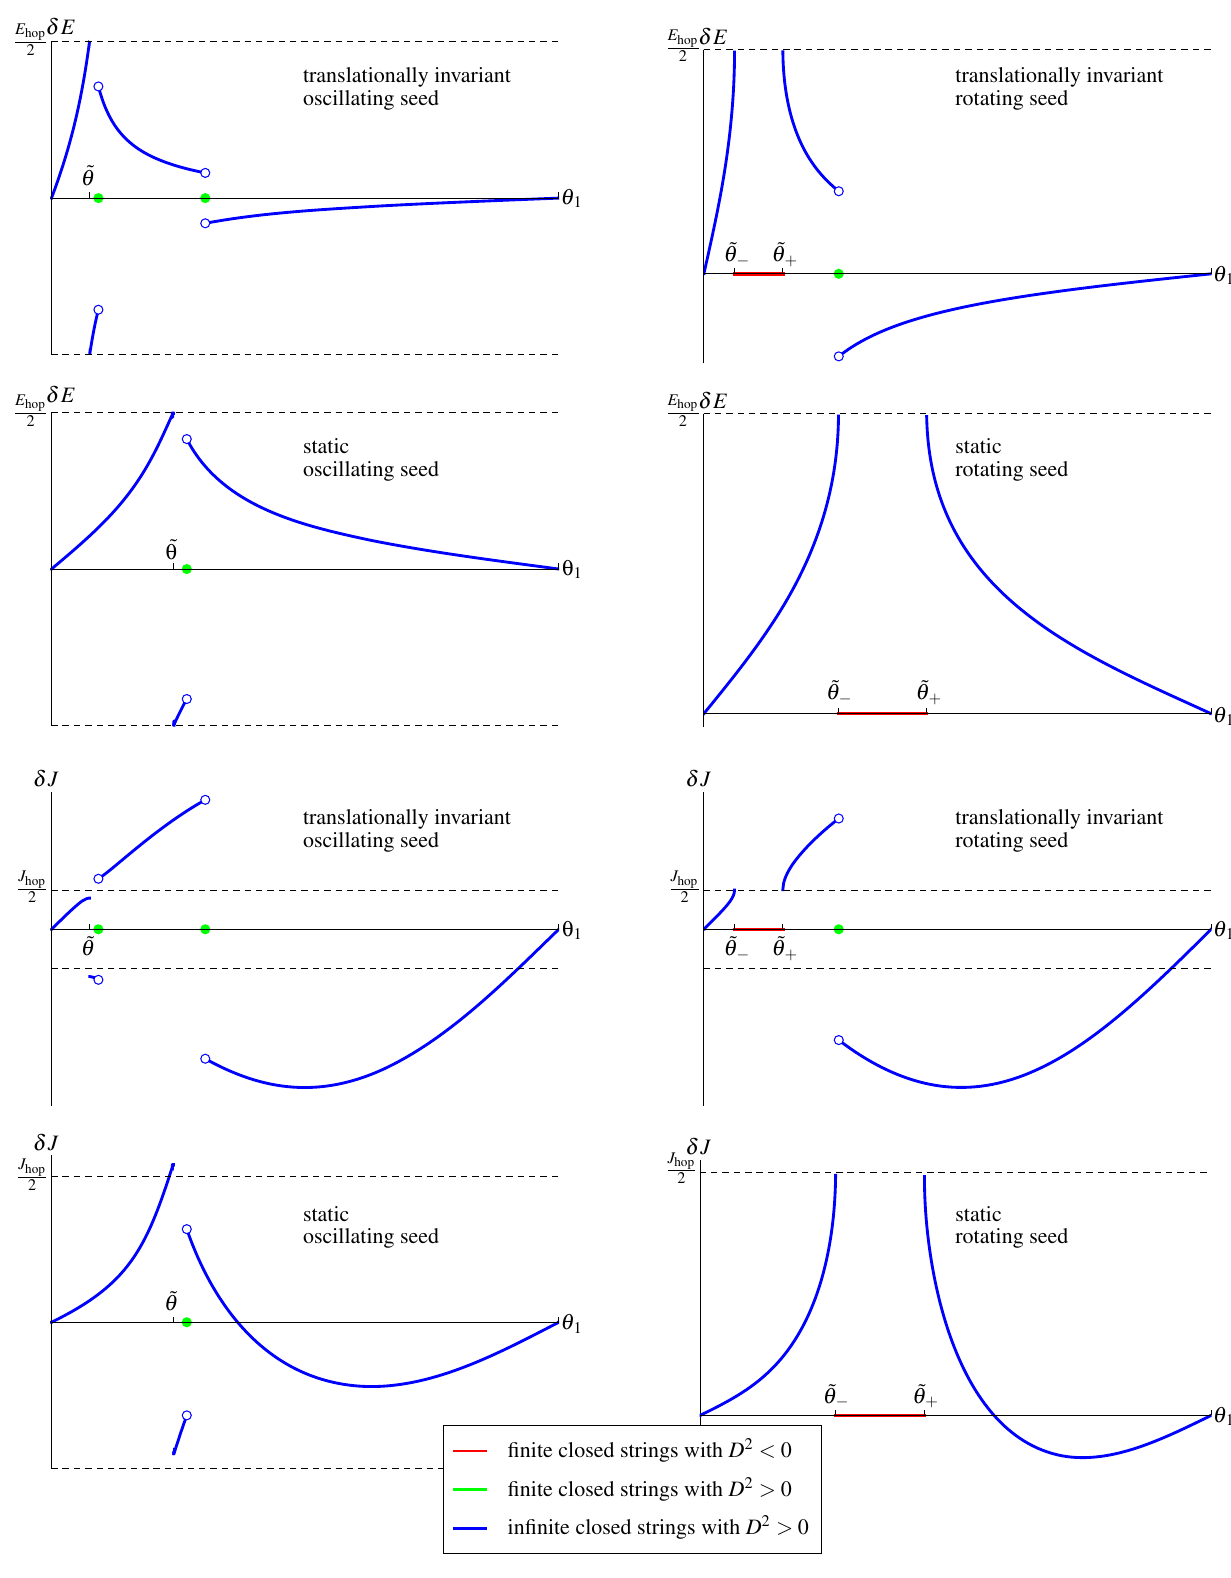
Fig. 27 The E dressed − E seed and J dressed − J seed as functions of the angle θ